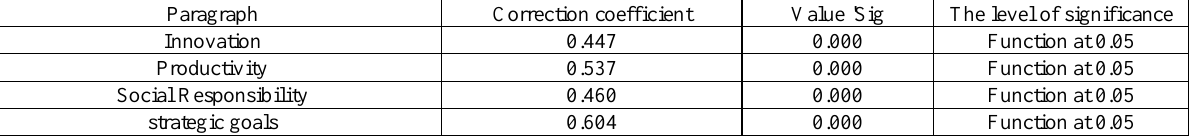
Table 19. Person's correlation transactions between freedom and independence and strategic goals